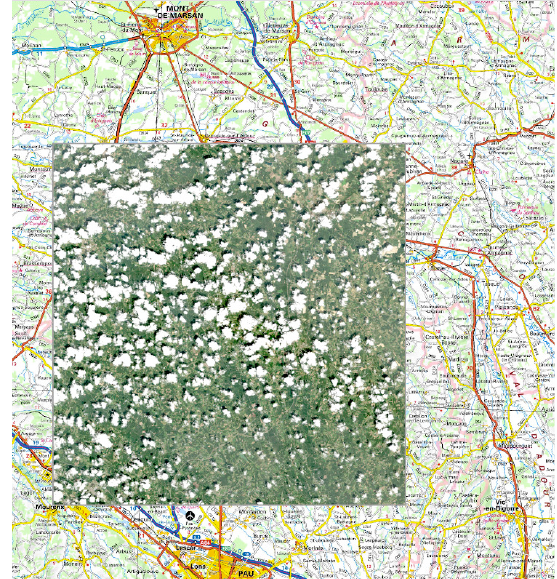
Figure 3. Initial Landsat 8 ortho-image (depicted here in a RGB mode) and its localisation in southern France.